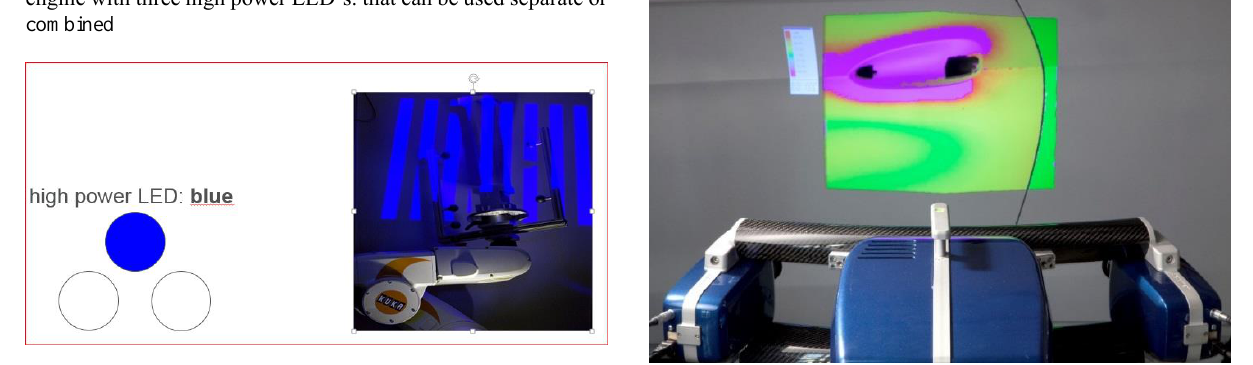
Figure 12a: Multi color projection - blue